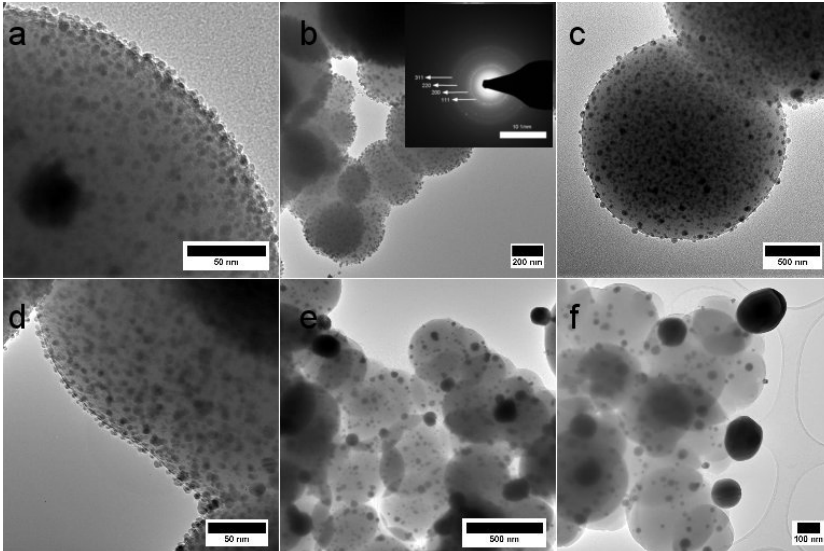
Figure 4. TEM images of ( a ) the dried SiO 2 -Ag powder and the powders heat treated at ( b ) 300 ◦ C [12]; ( c ) 400 ◦ C; ( d ) 500 ◦ C; ( e ) 700 ◦ C and ( f ) 800 ◦ C for 75 min. The lighter parts represent the silica matrix, whereas the darker spots are silver particles. The insert in ( b ) displays the electron diffraction pattern revealing crystalline silver particles after heat treatment at 300 ◦ C. Scale bars in ( a ) 50 nm; ( b ) 200 nm; ( c ) 500 nm; ( d ) 50 nm; ( e ) 500 nm and ( f ) 100